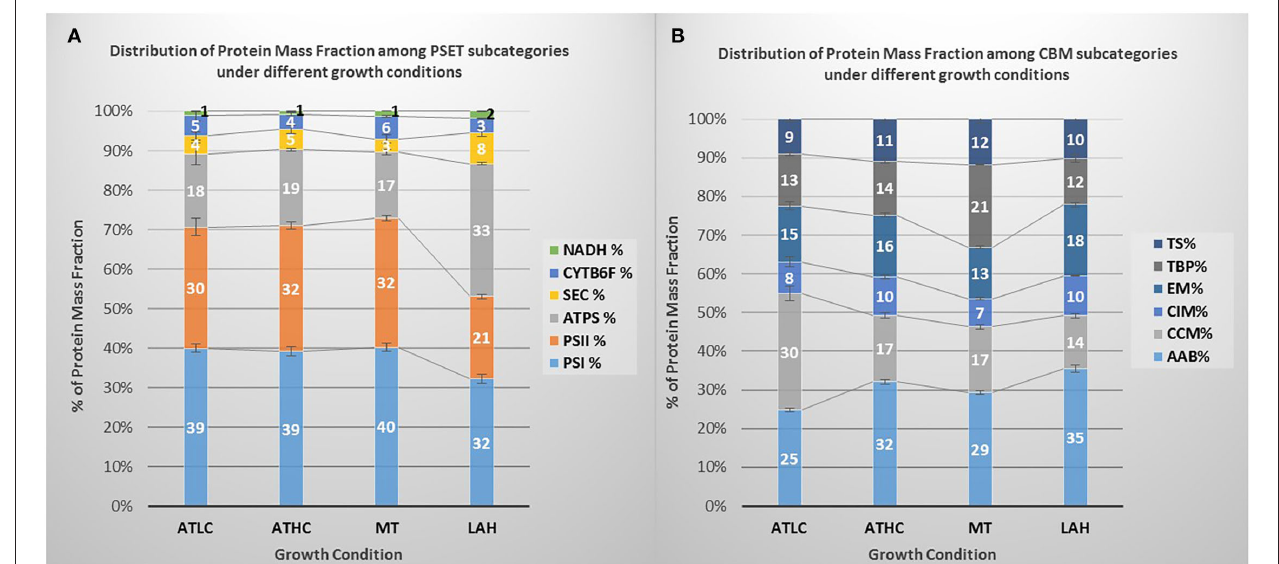
FIGURE 4 | Distribution of protein mass fraction in categories of (A) photosystems and photosynthetic transport (PET) and (B) relevant subcategories of carbon metabolism (CBM) under the different growth conditions: ATLC, ATHC, MT, and LAH. In (A) , PSI, photosystem I; PSII, photosystem II; ATPS, ATP synthase; SEC, soluble electron carriers, Cyt b 6 f -cytochrome b 6 f , NADPH-dehydrogenase complex (NDH-1 1 and NDH-2); in (B) , AAB, amino acid biosynthesis; CCM, carbon-concentrating mechanism; CIM, central intermediary metabolism; EM, energy metabolism; TBP, transport and binding proteins; TS, translation. Three to four biological replicates per condition were used to calculate proteome mass fractions and corresponding standard